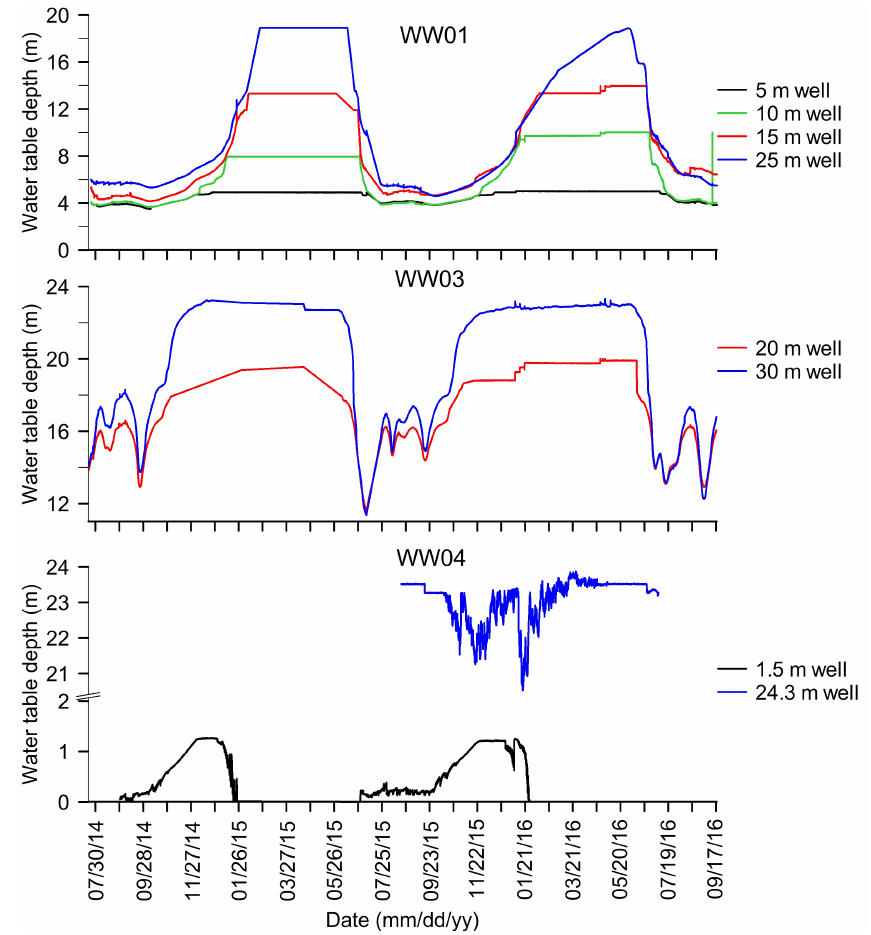
Figure 4. Time series of water table depth in the wells at cluster WW01, WW02 and WW04.